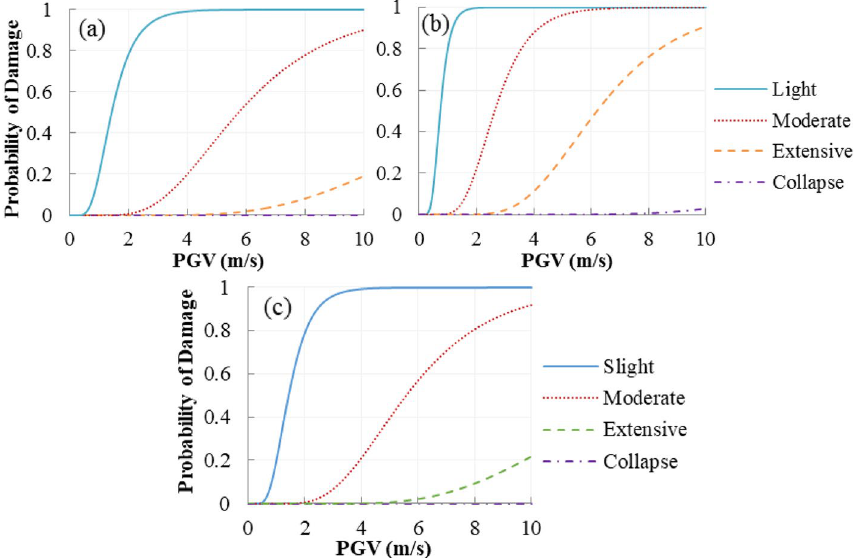
Fig. 12 Fragility curves of bridge tower ( a ) Floating System, ( b ) Rigid System, and ( c )